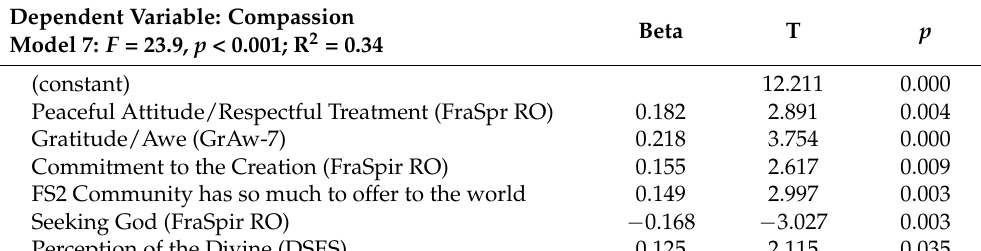
Table 5. Predictors of Compassion and Altruism (stepwise regression analyses).